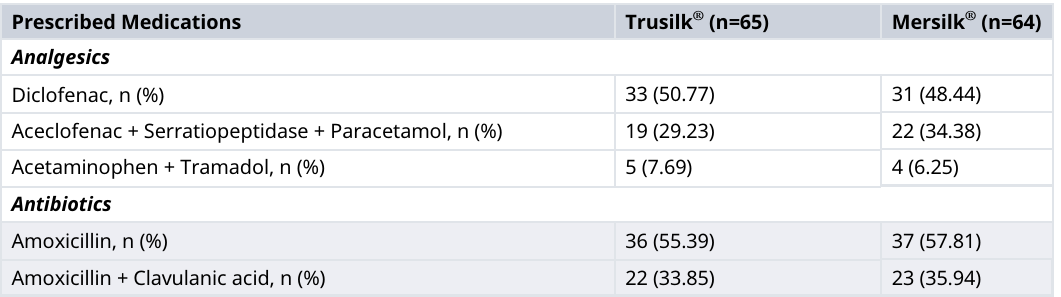
Table 4. Concomitant or prescribed medications in the study participants during the study